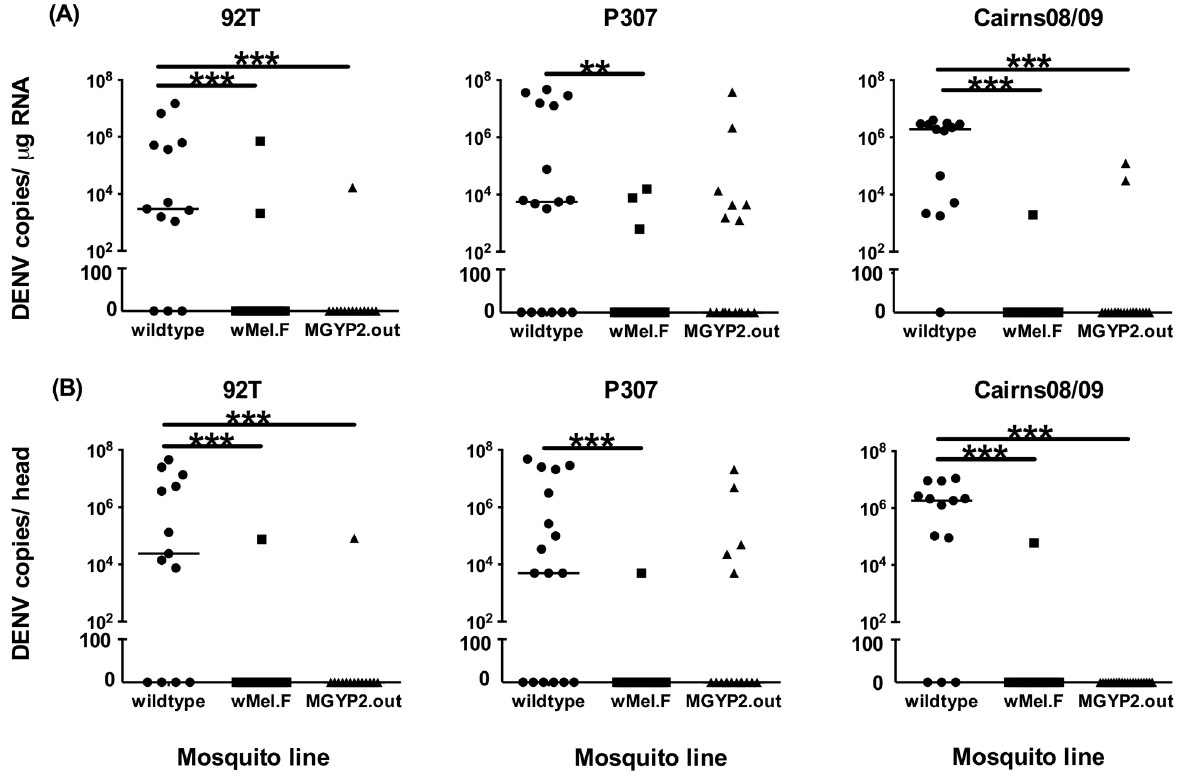
Figure 2. Experiment 2: DENV replication in wildtype, outbred laboratory w Mel (MGYP2.out) and field-released w Mel ( w Mel.F) A. aegypti . DENV replication in bodies (A) and heads (B) of mosquitoes challenged with three strains (DENV2-92T, DENV1-P307, DENV3-Cairns08/09), assayed at 14 days post-infection. DENV levels determined using one-step qRT-PCR and expressed as copies per 1 m g of total RNA. Bars denote medians. P , 0.05 (*), P , 0.01 (**), P , 0.001 (***). Each point represents an individual mosquito.